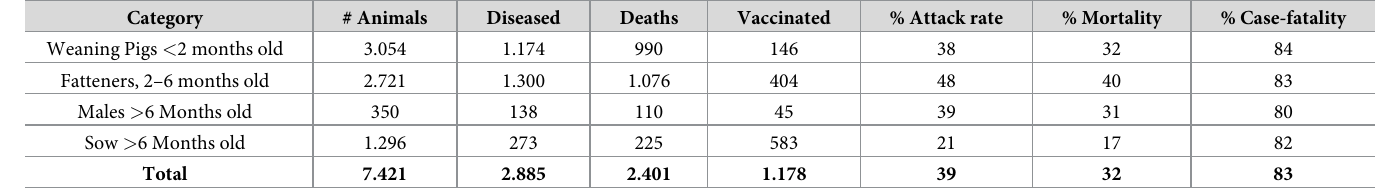
Table 4. Morbidity and mortality rates due to CSF in the 134 outbreaks, classified by age and gender. Category # Animals Weaning Pigs < 2 months old Fatteners, 2–6 months old Sow > 6 Months